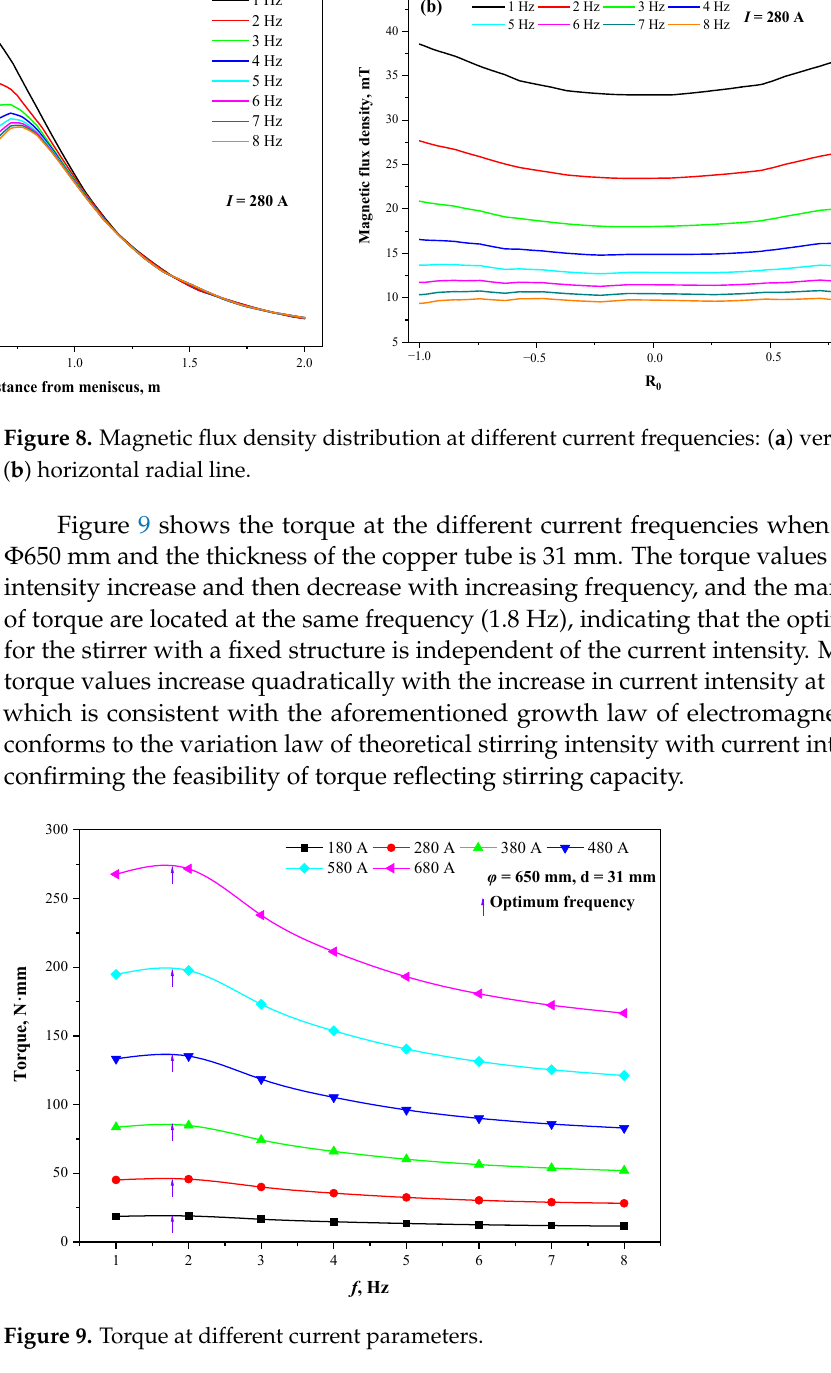
d = 37 mm I = 280 A Figure 10. Effect of different thickness of mold copper tube on stirring intensity. When the M-EMS center coincides with the center of the strand, the electromagnetic force distribution on the cross-section of the strand in the center of the stirrer, at the cur- rent intensity of 280 A and frequency of 2 Hz, is shown in Figure 11. When the section size is reduced from Φ650 mm to Φ550 mm, the thickness of the mold copper tube is reduced